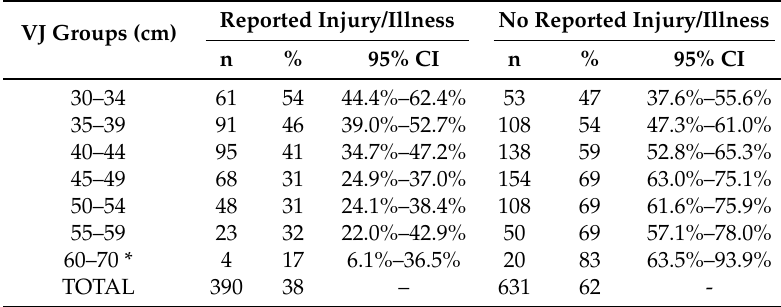
Table 3. Vertical jump score comparison for trainees reporting injury and/or illness versus those reporting no injury or